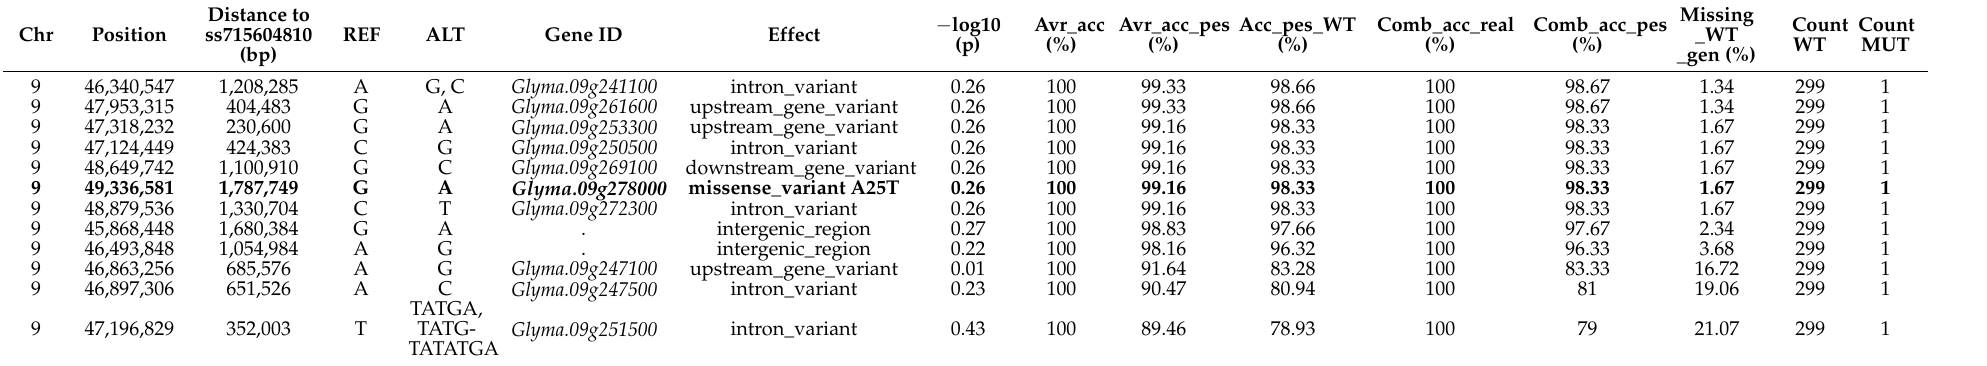
Table 1. Selection of the highest Avr_accu (100%) variant positions to the glabrous/pubescent phenotype in the 4M bp genomic region on chromosome 09. The table was derived from the AccuCalc analysis output (at https://github.com/Biovj/AccuCalc/tree/main/publication_files, accessed on 27 December 2022) and simplified. The causative mutation position of Glyma.09g278000 -A25T is in